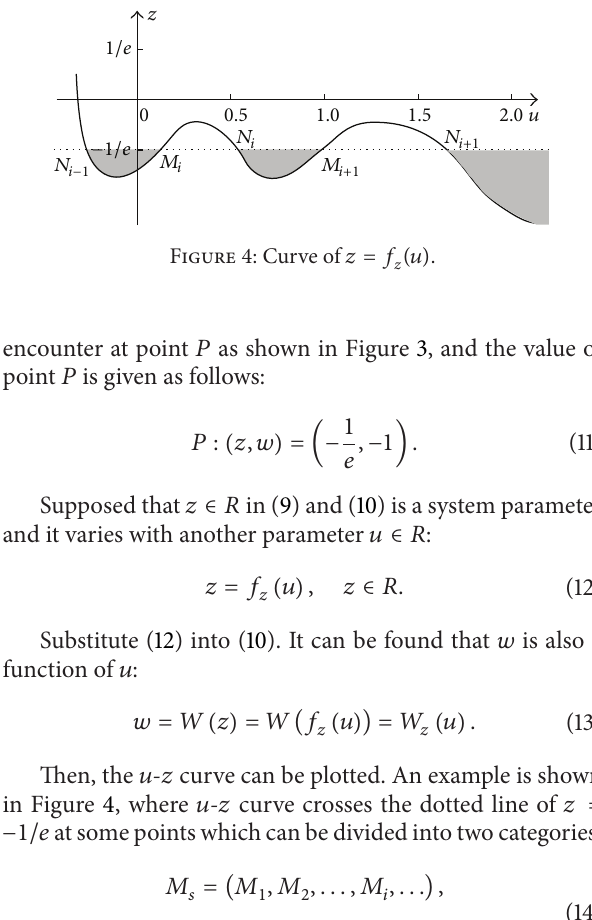
Figure 3: 𝑊 0 and 𝑊 −1 branches of Lambert 𝑊 function.